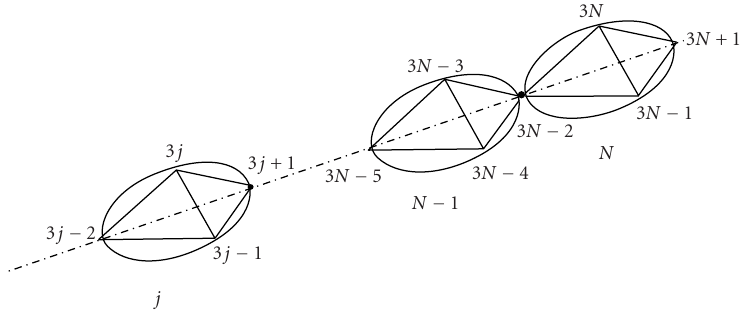
Figure 2.3. Serial chain of N rigid bodies with the equivalent system of primary